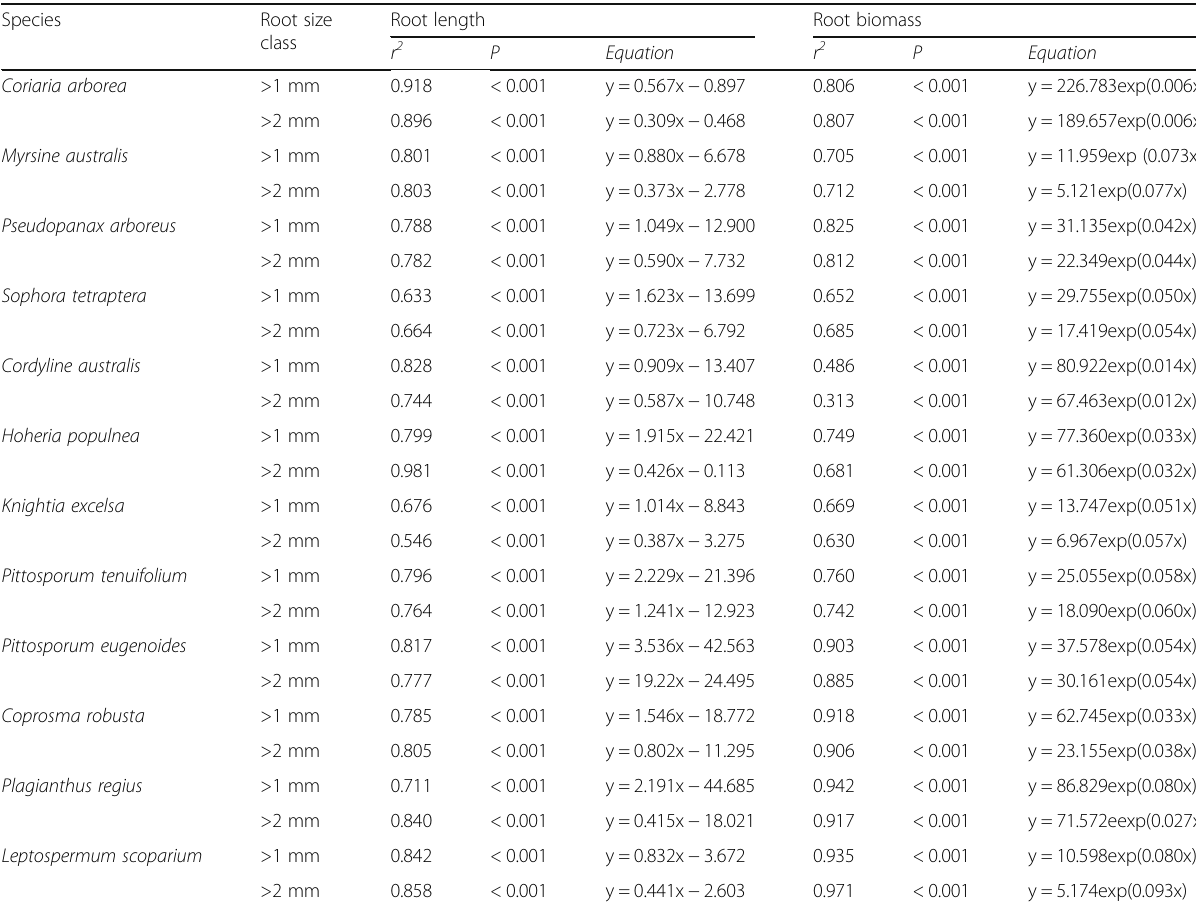
Table 6 Regression analyses for RCD against total root length and biomass for roots > 1 and > 2 mm diameter